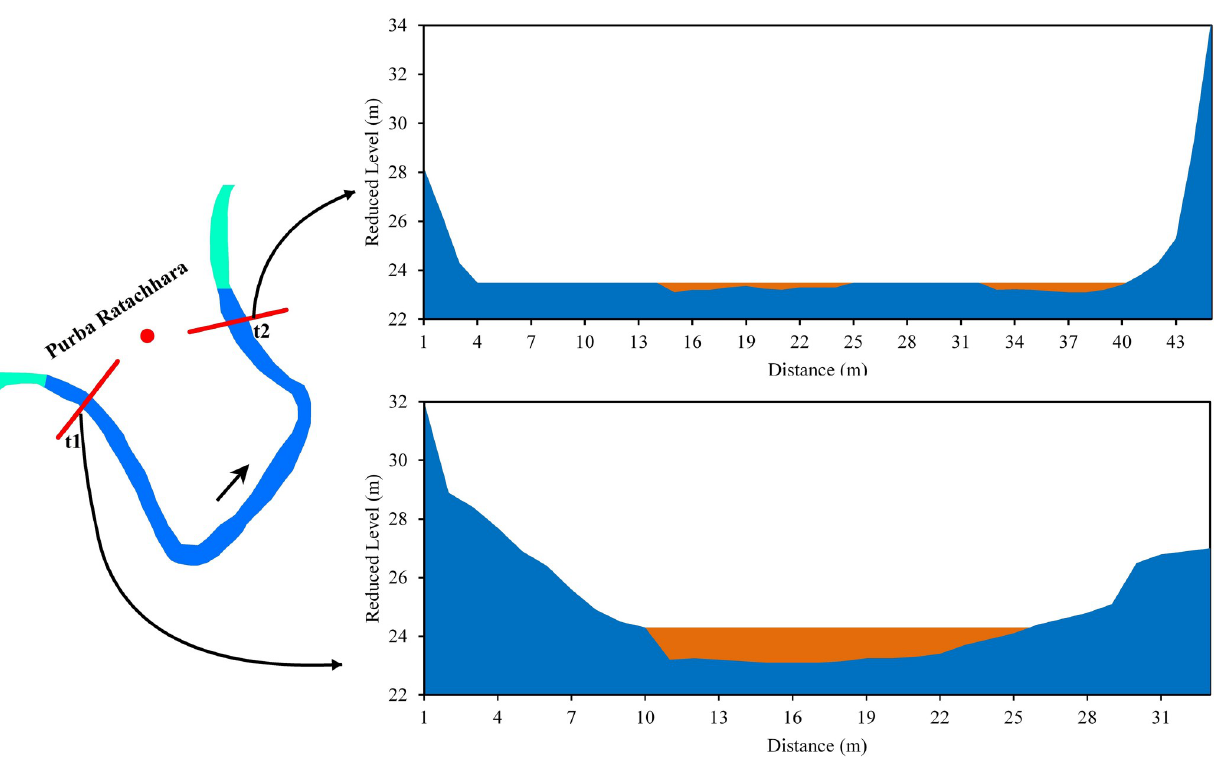
Fig 10. Cross-section across the Manu River at Purba Ratachhara (a) t1 (b) t2.